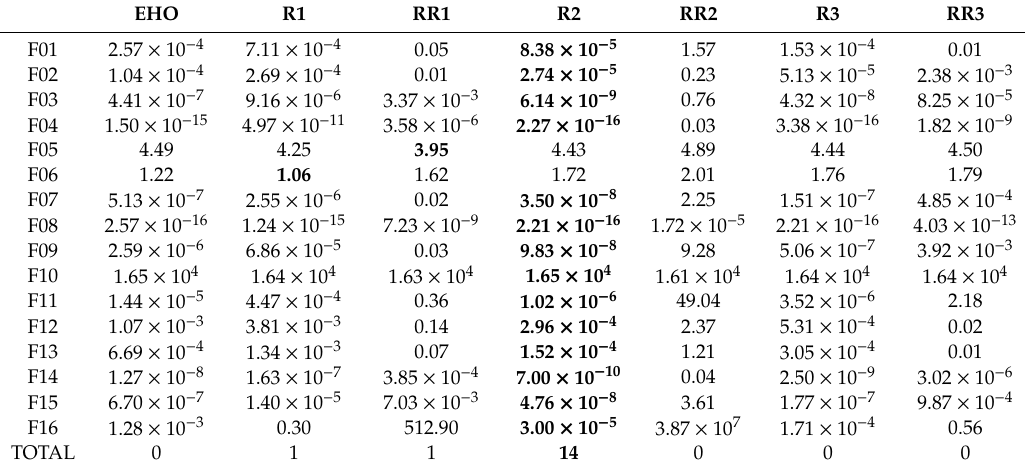
Table 2. Mean function values obtained by elephant herd optimization (EHO) and six improved methods with D = 50.